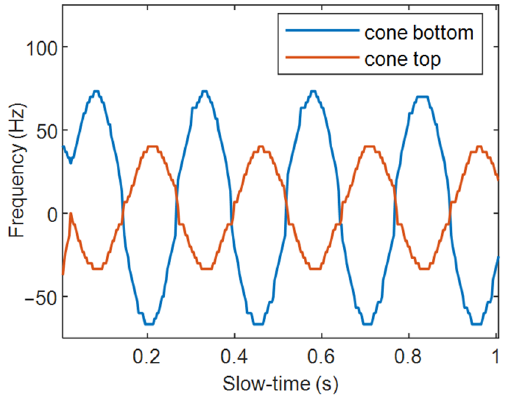
Figure 8. Skeleton extraction of echo micro-Doppler frequency curve. ( a ) Result of smooth processing. ( b ) Result of binarization processing. ( c ) Result of skeleton extraction. The skeletons of the micro-Doppler curves are separated, and the separation results are shown in Figure 9.